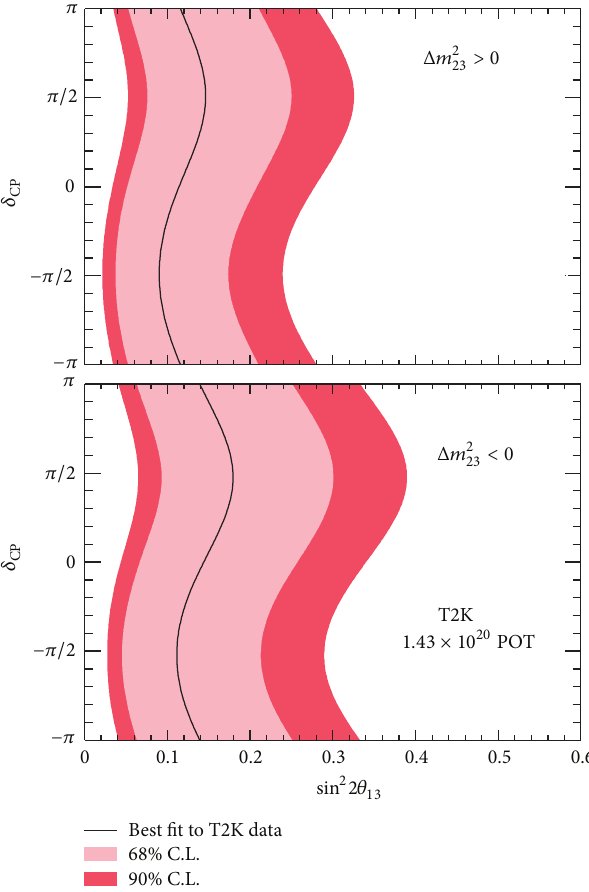
Figure 21: Allowed regions in the sin 2 2𝜃 13 - 𝛿 plane from the T2K 𝜈 𝑒 appearance measurement. Light (dark) red areas are 68% C.L. and 90% C.L. regions. Solid black curves are best fit